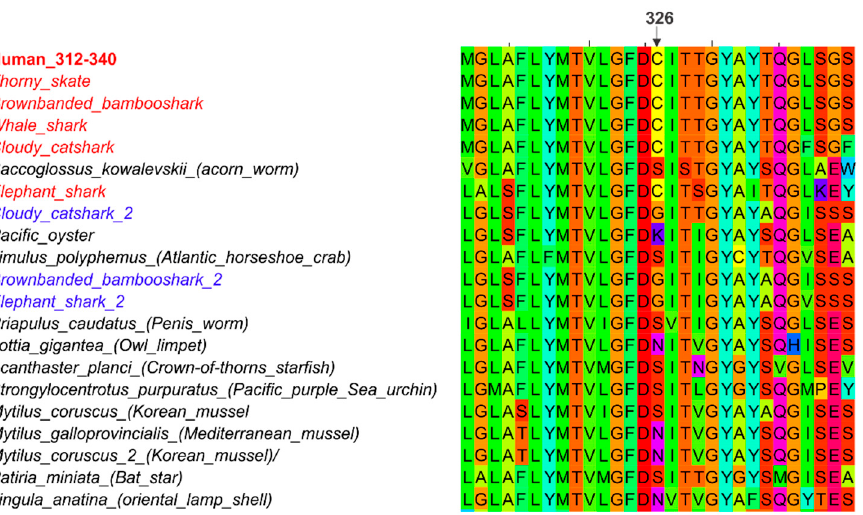
Figure 5. Although ferroportin is evolutionarily ancient, the thiol cysteine required for hepcidin binding by ferroportin appears first in early vertebrate ferroportins. Cartilaginous fish ferroportin that contains the C326-equivalent is denoted with species name in red. Second ferroportin in cartilaginous fish that has another amino acid in this position is denoted with species name in blue. Invertebrate ferroportin lacks C326 and is denoted with species name in black.